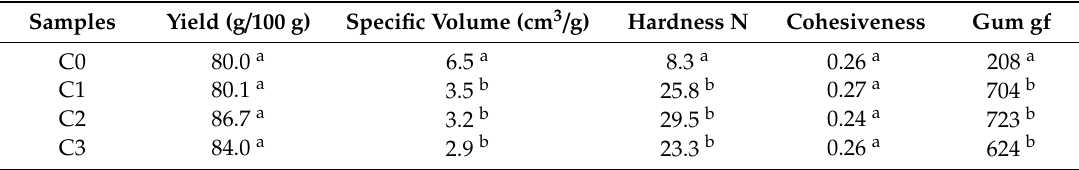
Table 4. Physical and textural characteristics of cupcake simples.